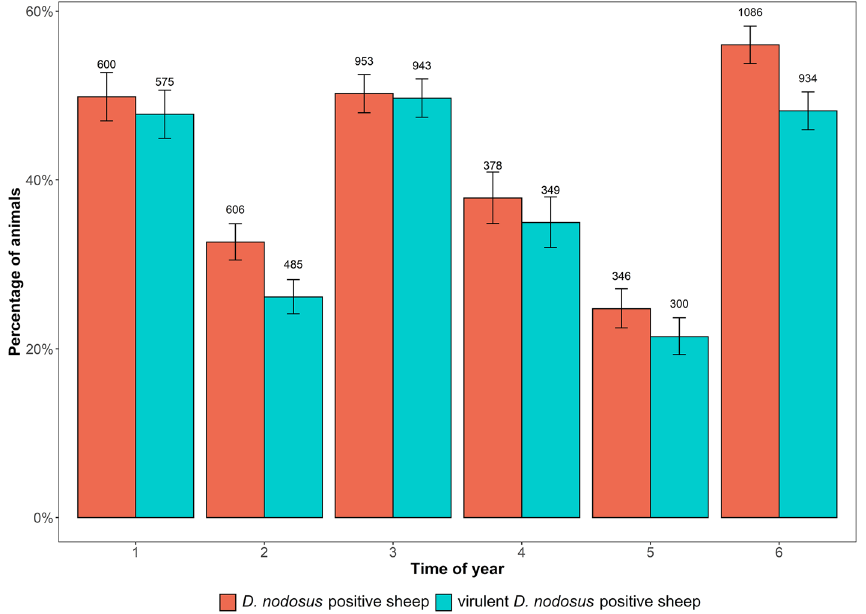
Figure 1. Percentage of animals tested positive for D. nodosus ( aprV2 + and/or aprB2 +) (red) and for virulent D. nodosus ( aprV2 +) (blue) at different times of the year, with 1 = Jan–Feb, 2 = Mar–Apr, 3 = May–Jun, 4 = Jul– Aug, 5 = Sep–Oct, 6 = Nov–Dec. Confidence intervals (95%-CI) and the total number of sampled sheep are also